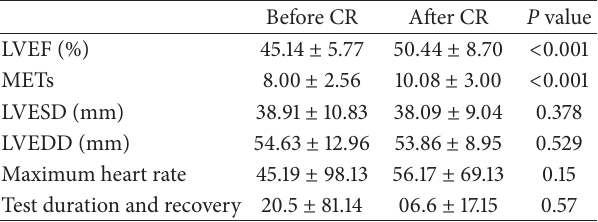
Table 2: Echocardiographic data of patients before and after the rehabilitation